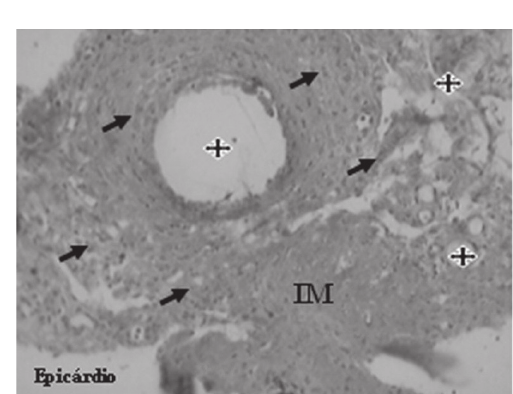
Fig. 5 - Neovasos (estrelas) e células endoteliais (flechas) após o transplante de células mesenquimais no infarto do miocárdio (IM) - Tricrômio de Gomery, x200